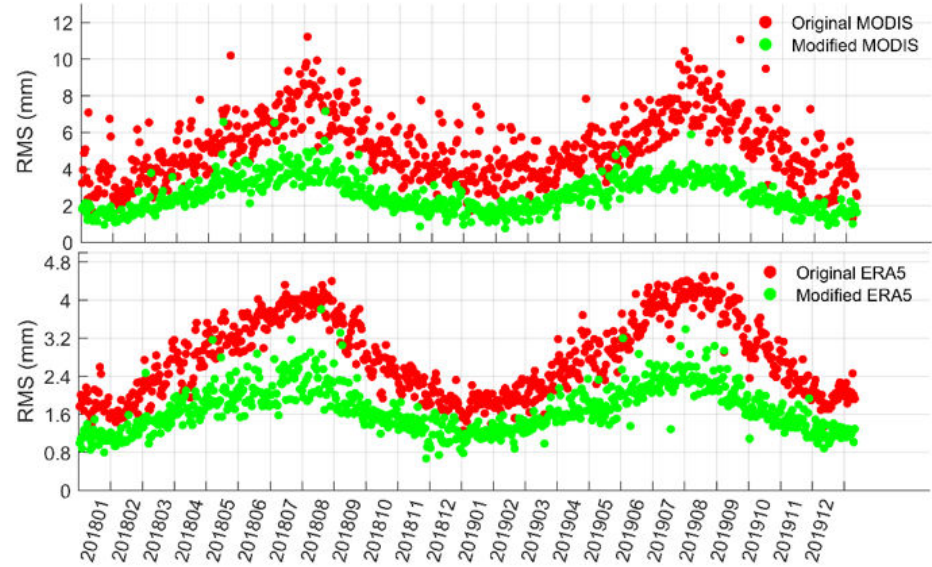
Figure 8. Daily PWV RMS of the original MODIS (ERA5) PWV and the modified MODIS (ERA5)